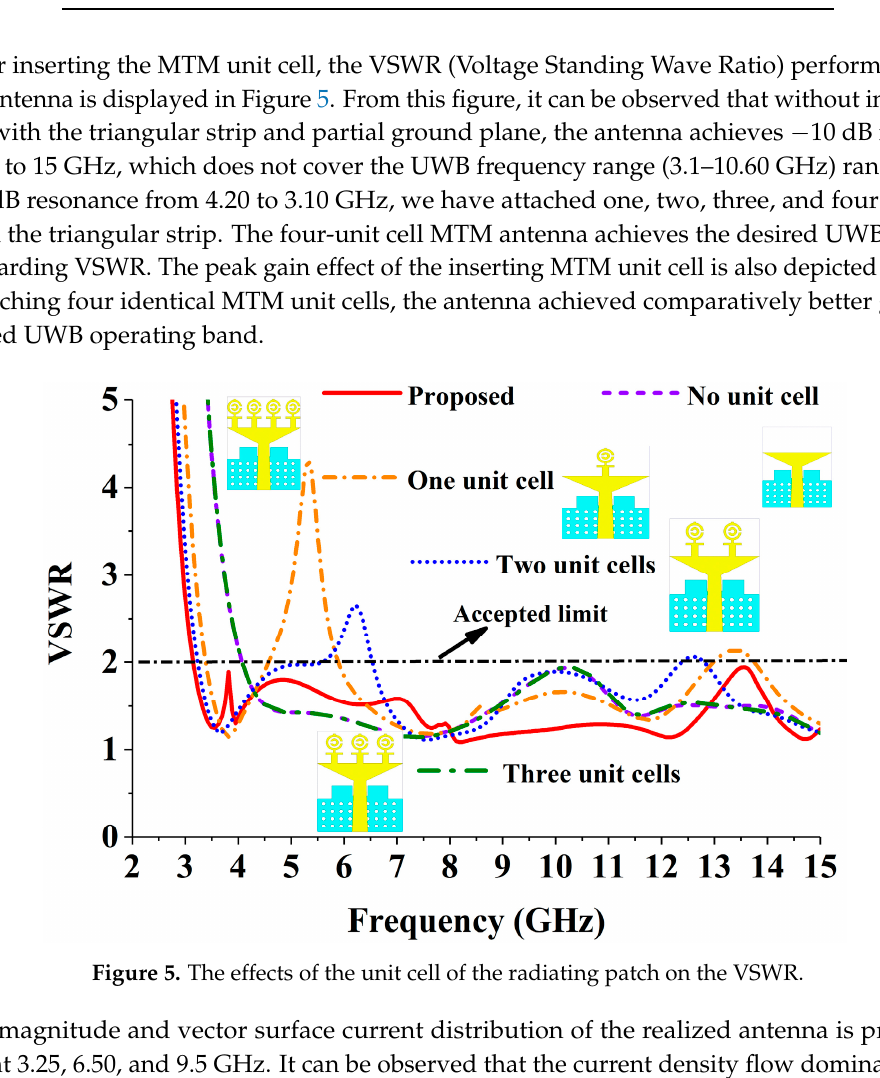
Table 3. Antenna design parameters according to Figure 4.